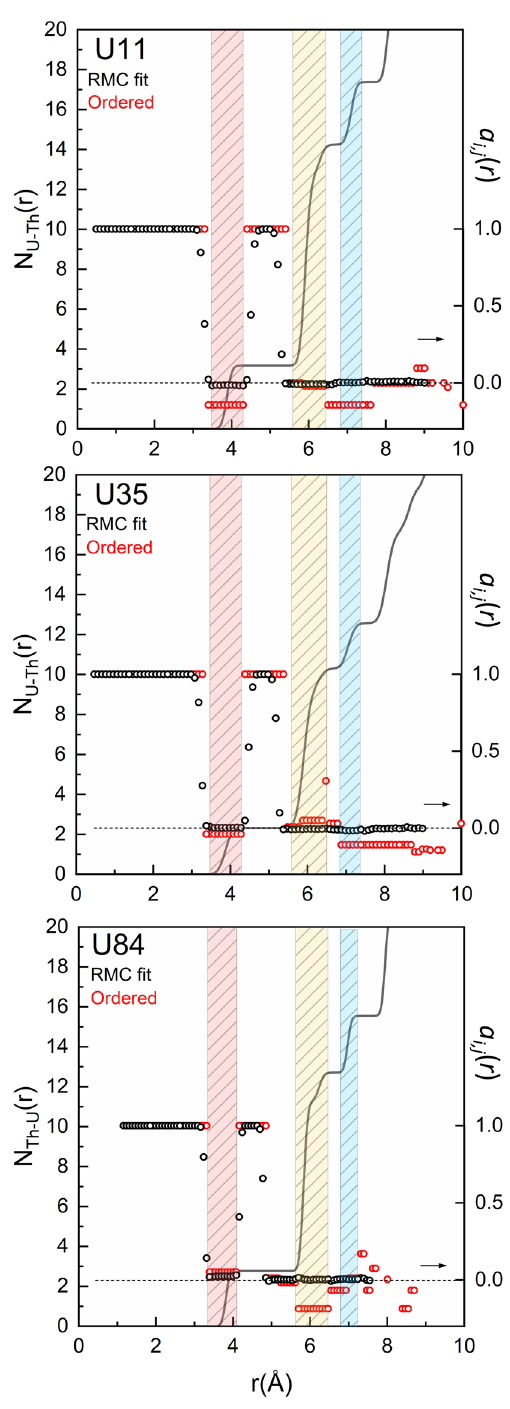
Fig. 6 The coordination numbers and Warren – Cowley parameters of U – Th pairs. The coordination number distribution functions N( r ) obtained through RMCPro fi le are shown as solid black lines (referred to left axis). The statistically calculated Warren – Cowley parameters, α (referred to right axis, values from − 0.3 to 1.0), for RMC fi ts and fully ordered models are depicted in black and red open circles, respectively, for RMC fi ts and fully ordered models. The coordinates covered by red, yellow, and blue correspond to the U – Th pairs in their nearest neighbors in the a – b planes, the second nearest, and the third in the a – b planes, respectively. The dashed black line indicates the value of α in the case of random distribution of U and Th